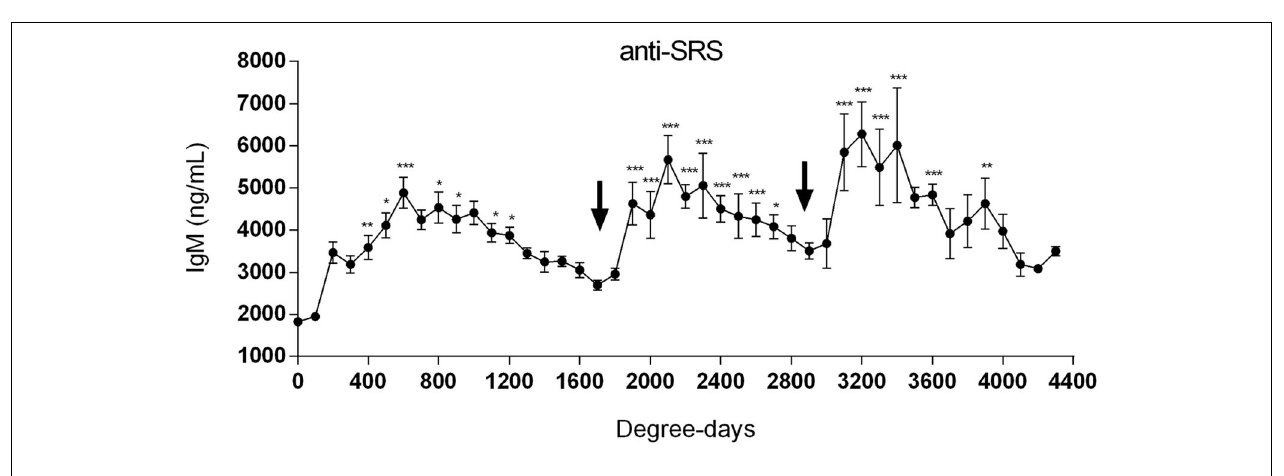
vaccines were administrated, respectively. Serum samples were obtained at different degree-days to determine specific IgM anti- P. salmonis . Samples were statistically analyzed by one-way ANOVA – Dunnet post-test. (SRS 150 fish/point, ISAv 70 fish/per point) * p < 0.05; ** p < 0.01; *** p < 0.001.